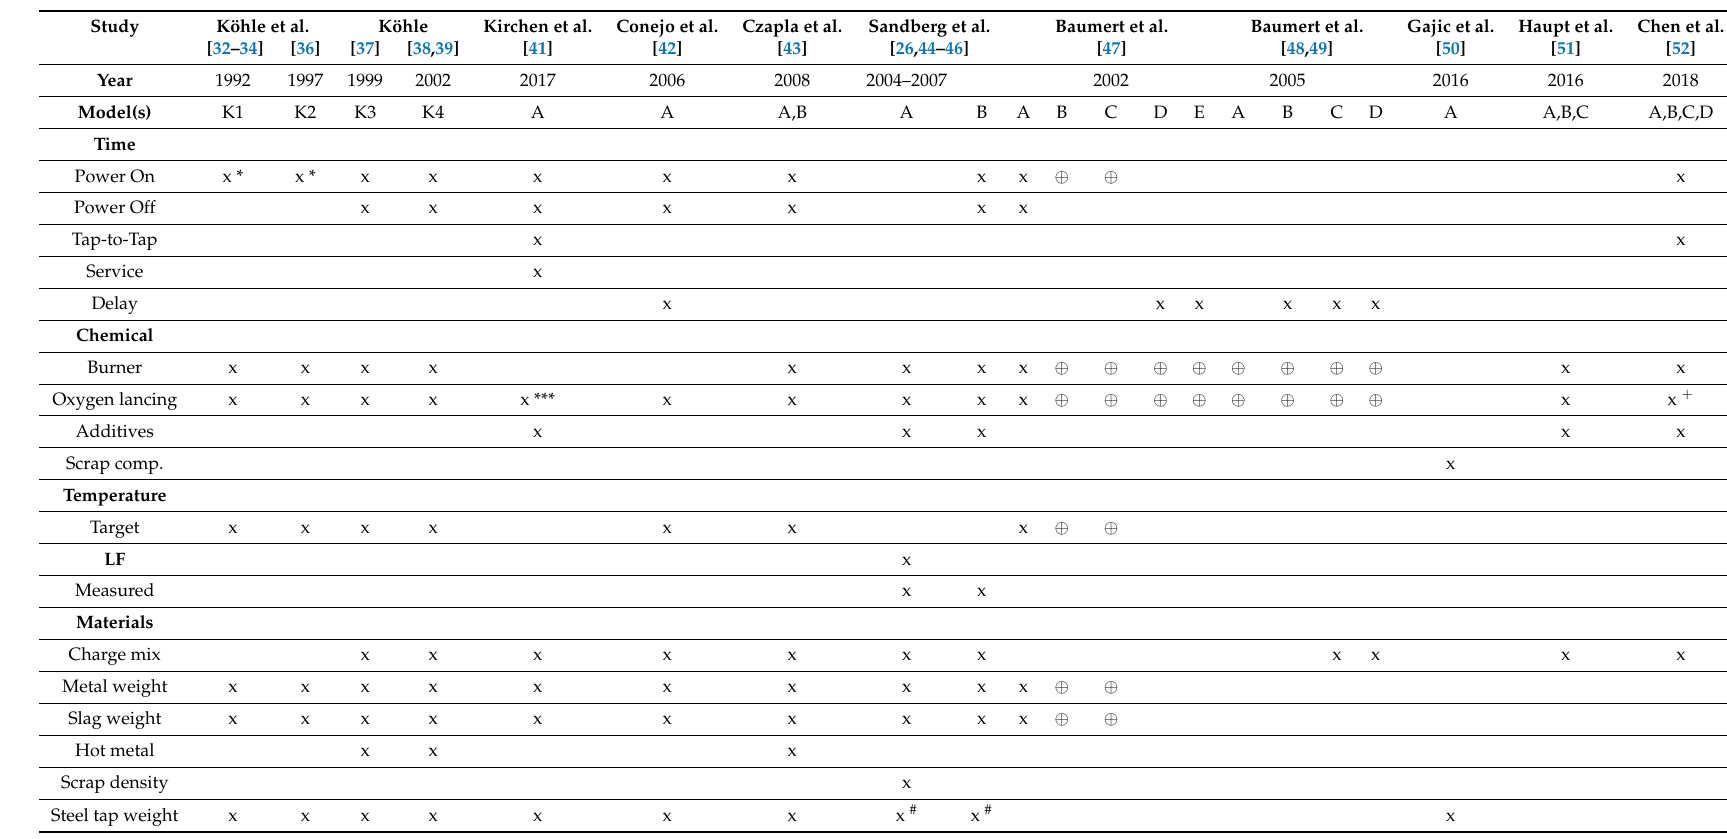
Table 4. Input variables used in each study creating new statistical models. The models are labeled in alphabetical order with respect to the study where they are created. Köhles’ models are labeled K1–K4 for distinction purposes because they are the only models that are used in multiple studies. * Defined as time from first power on to start of tapping. ** Average Power (MW). *** Total oxygen input ( m 3 ), + Main and secondary oxygen, ++ Number of heats since a longer production stop. +++ Except preheating energy. ⊕ Indirect input variable due to being part of the energy variable calculations. # From another statistical model. ## Not specified which energy variables were